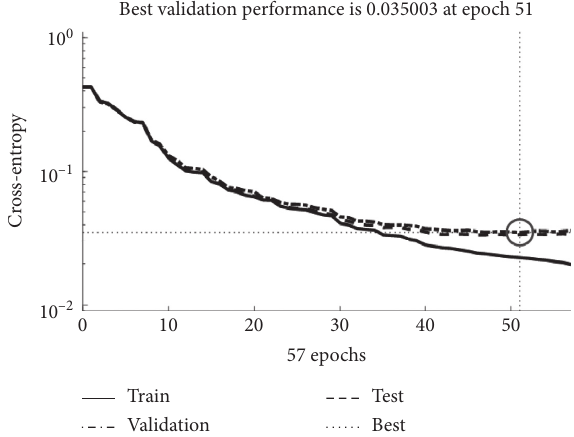
Figure 6: Output prediction error of the ANN after each training